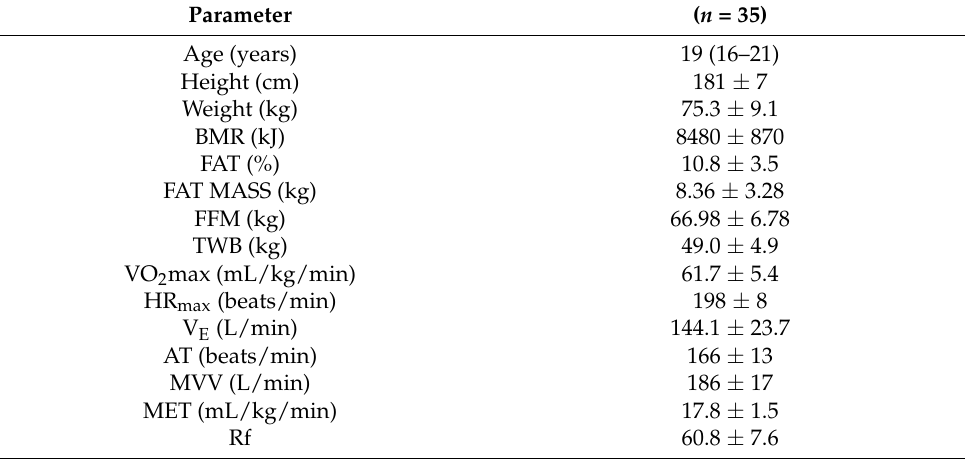
Table 1. A baseline characteristic of the